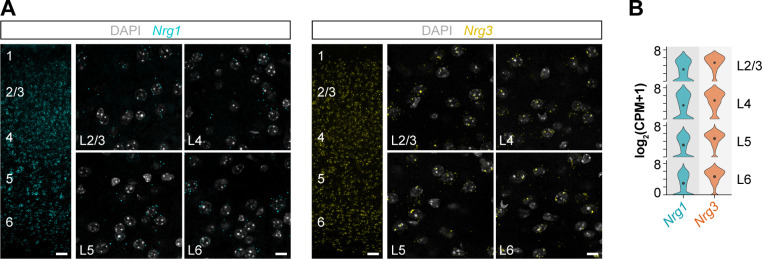
Cellular expression of Nrg1 and Nrg3 mRNA in the mouse cerebral cortex, related to Figure 1.(A) Single-molecule fluorescent in situ hybridization with Nrg1 and Nrg3 RNAscope probes in coronal sections through somatosensory cortex at P30. Nrg1 and Nrg3 mRNA expression is abundantly detected across layers 2–6 in the mouse cerebral cortex. (B) mRNA expression of Nrg1 and Nrg3 in pyramidal cells across cortical layers at P56. The violin plots depict single-cell RNA-sequencing data from the RNA-Seq Data Navigator at the Allen Brain Atlas (http://celltypes.brain-map.org/rnaseq/mouse). Scale bars, 50 µm (A) and 10 µm (high magnifications).